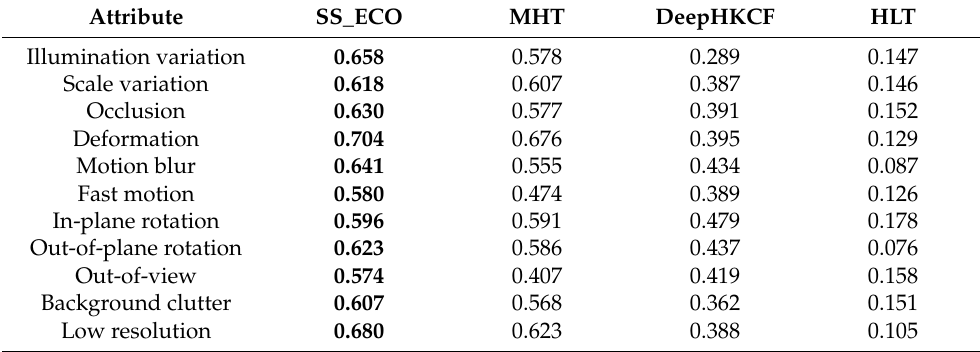
Table 7. Attribute-based comparison with hyperspectral trackers in the term of AUC. The best results are shown in